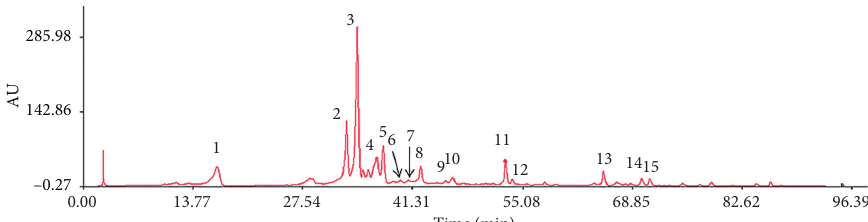
Figure 3: HPLC fingerprint of total flavonoids of Glycyrrhiza uralensis Fisch. from 21 producing